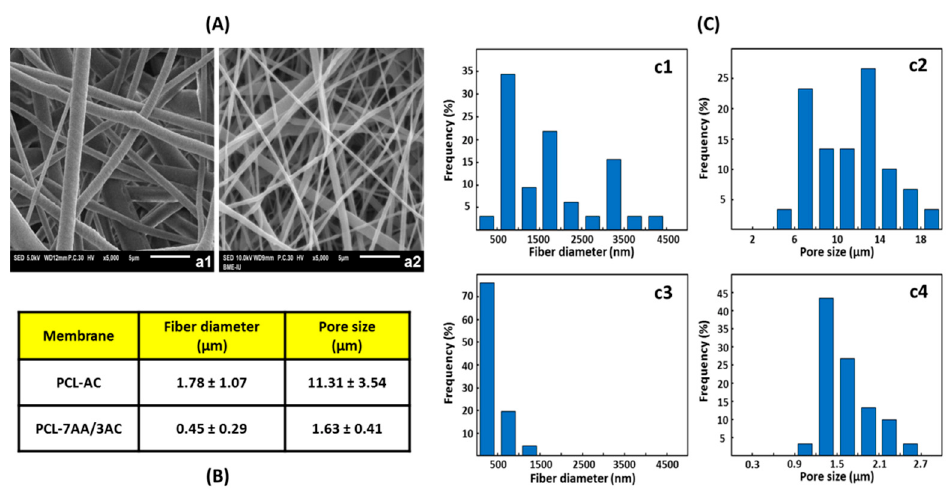
Figure 2. ( A ) Scanning Electron Microscope (SEM) images of electrospun polycaprolactone (PCL) in acetone (AC), (PCL-AC), (a1) and PCL dissolved in acetic acid (AA)/AC (7:3, PCL-7AA/3AC) (a2) membranes, ( B ) Average fiber diameter and pore size, and ( C ) Histogram of fiber diameter and pore size distribution of PCL-AC (c1,c2) and PCL-7AA/3AC (c3,c4) membranes.